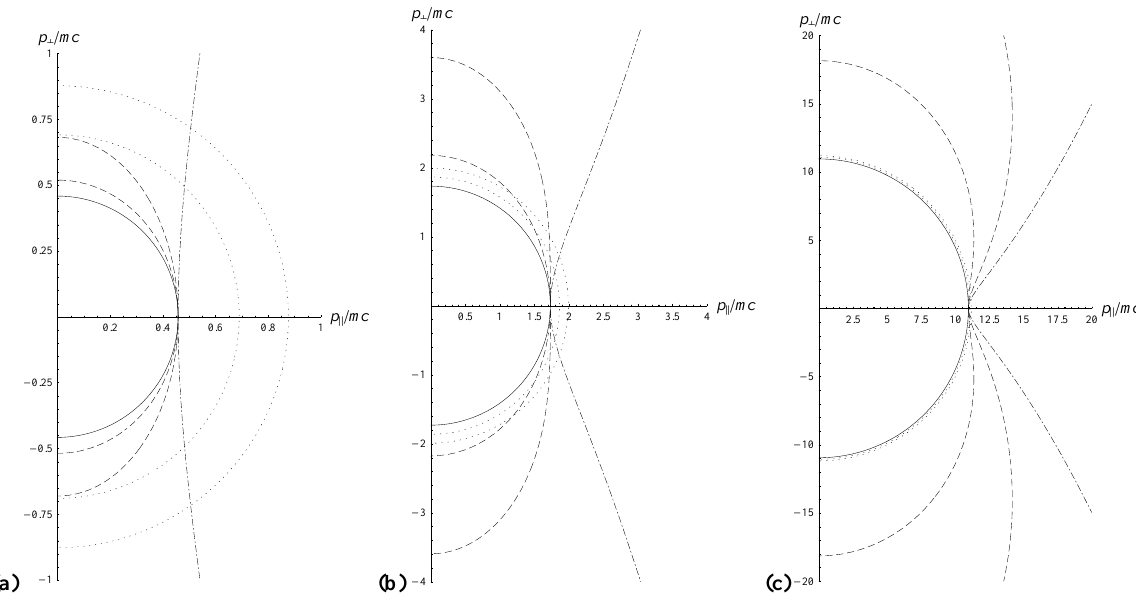
Fig. 1. Cuts through momentum space in the (cid:0) p ⊥ ,p || (cid:1) plane, showing contours of constant distribution function (solid and dotted circles) for (cid:16) . (cid:17) = 20 which is accelerated through field-aligned mc 2 kT an initially Maxwellian distribution with non-relativistic temperature such that (cid:16) . (cid:17) = 0 . 1, 1, and 10 in panels (a) , (b) , and (c) , respectively. The solid circle in each plot represents the inner limit of the e8 mc 2 potentials of distribution (for (cid:0) B (cid:14) B o (cid:1) →∞ ) , while the inner and outer dotted circles show the surfaces where the distribution function falls to factors of 0.1 and 0.01 of the value on the solid circle, respectively (given by Eq. 6 combined with Eq. 1). These dotted contours can only just be seen outside the solid circle in case (c). The dot-dashed and dashed lines then show where these distributions are truncated in momentum space for finite (cid:0) B (cid:14) B o (cid:1) beneath the voltage drop, given by Eq. (7b), the full surfaces being obtained by revolution about the p || axis. The dot-dashed line in each plot corresponds to (cid:0) B (cid:14) B o (cid:1) = 1 directly beneath the voltage drop, while the two dashed lines correspond to (cid:0) B (cid:14) B o (cid:1) = 2 and 5. The solid line shows the limiting surface for (cid:0) B (cid:14) B o (cid:1) →∞ , such that the accelerated distribution then becomes fully isotropic.